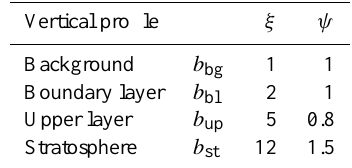
Table 3. Parameters for the aerosol vertical profile assumed in the forward